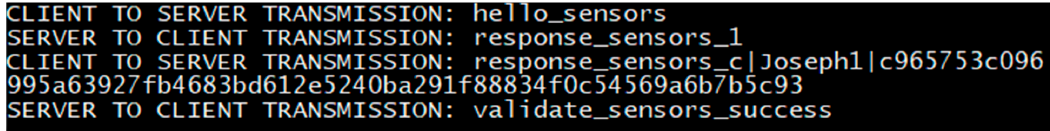
Figure 15. Intercepted data from client and server using a simple hash comparison login—hashing on the server side. Figure 16. Intercepted data from client and server using a simple hash comparison login—hashing on the client side.